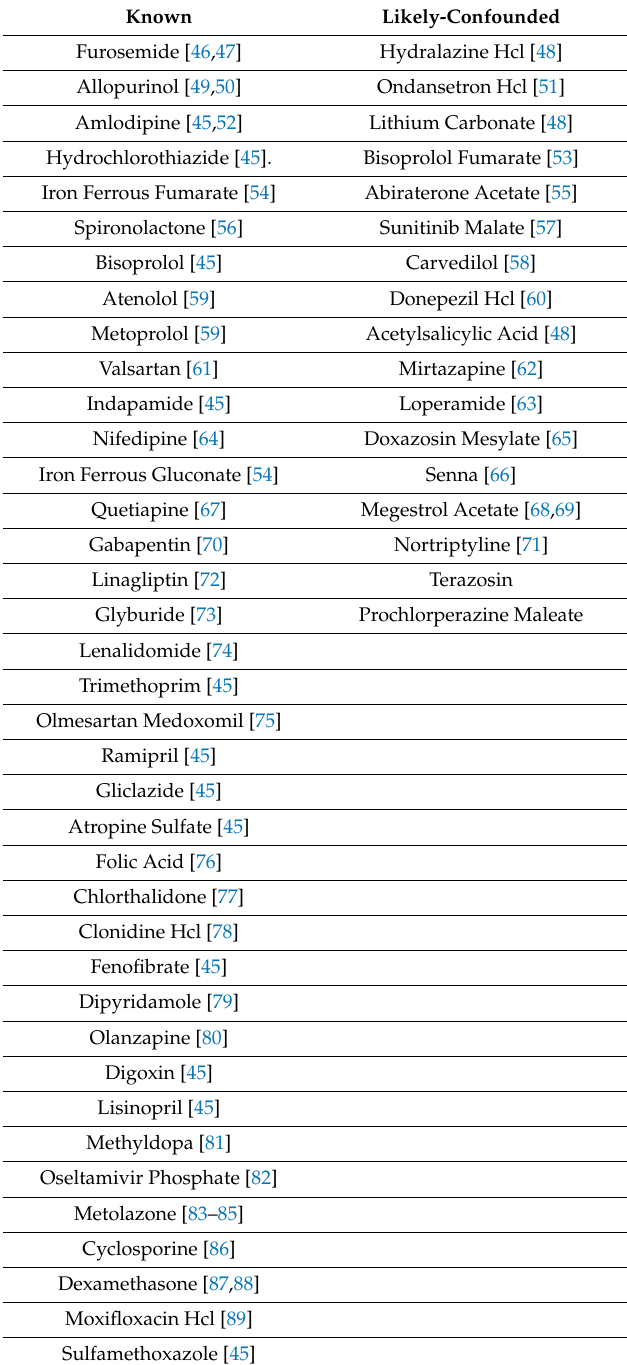
Table4. Thelistofstatisticallysignificantmedicationsfromindividualanalysis,